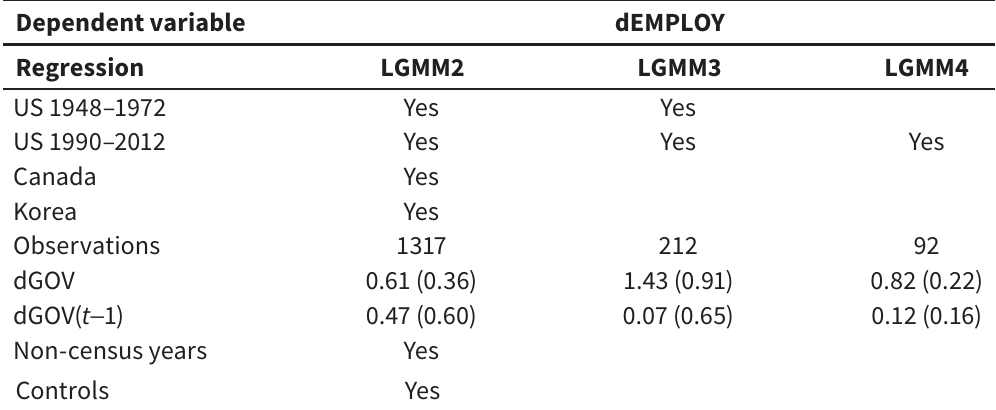
GMM with lags Dependent